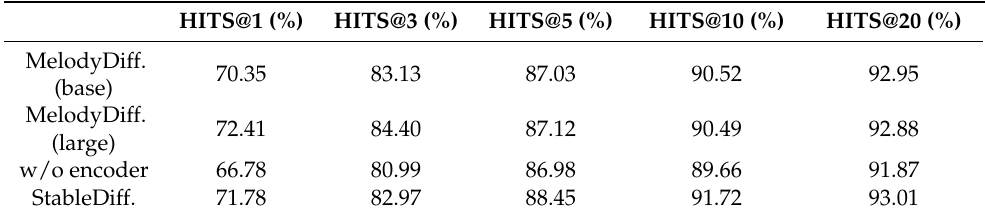
Table 6. Evaluation results of the generated melodies obtained using